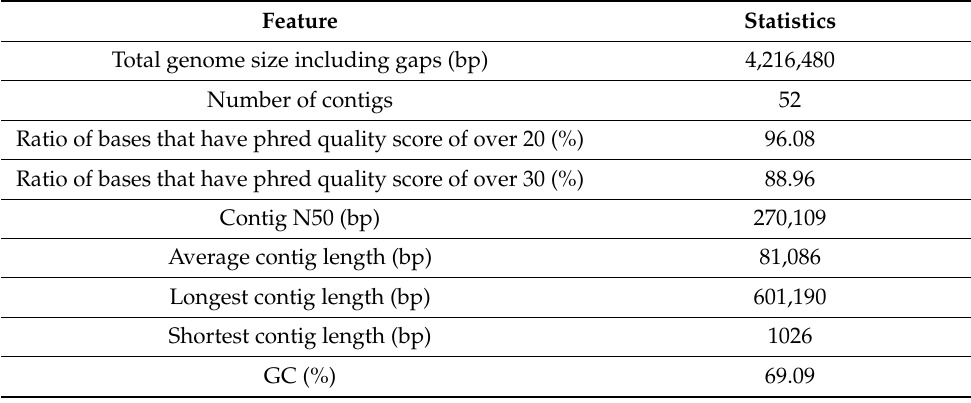
Table 1. Whole genome statistics.